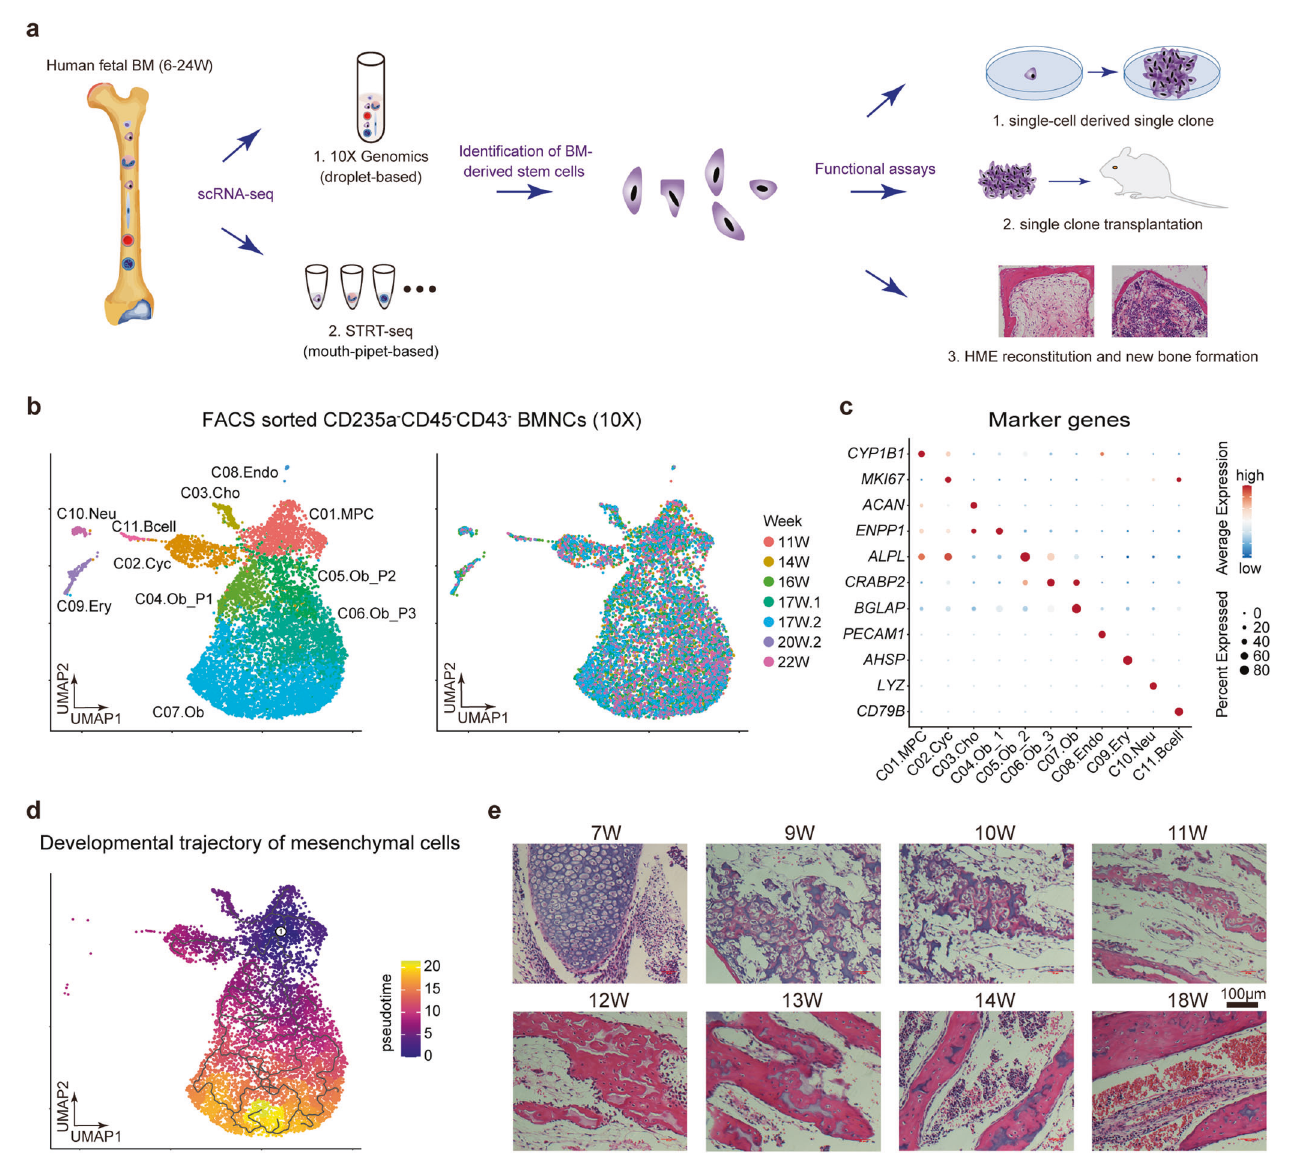
Fig. 1 Expression landscape of human fetal BM stromal cells. a Diagrammatic sketch of the current study. b UMAP showing the clustering (left) and week information (right) of all FACS-sorted CD235a - CD45 - CD43 - nucleated cells sampled from the human fetal bone marrow, which were sequenced by 10x Genomics scRNA-seq technique. c Dotplot showing the expression patterns of representative marker genes in each major cluster identi fi ed in Fig. 1b. The color key from blue to red indicates low to high expression levels, respectively. Dot size indicates the percent of cells expressing a certain gene. d Developmental trajectory of mesenchymal cells inferred by monocle 3 algorithm. e H&E staining of femur sections from different embryonic